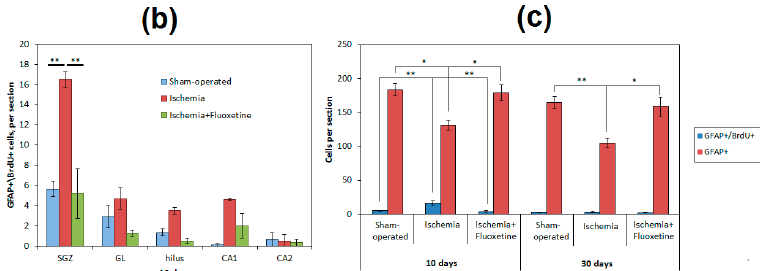
Figure 3. Fluoxetine effect on neural stem cell recruitment in the DG. ( a ) Micrographs of the DG of the hippocampus in the sham-operated animals, positive controls, and fluoxetine-treated animals at day 11 after GCI. Brain sections were stained with BrdU, GFAP and DAPI, 63× magnification. NSCs are indicated by arrows; ( b ) Comparison of GFAP+\BrdU+ cells in hippocampal regions between the groups at day 11 ( b ) after surgery; ( c ) Comparison of GFAP+\BrdU − (quiescent NSC) cells and GFAP+\BrdU+ (recruited NSC) cells in the SGZ between the groups at days 11 and 31 after surgery. Significant differences between the groups, according to ANOVA after Bonferroni’s correction for multiple comparisons: ** p < 0.01, * p < 0.05.